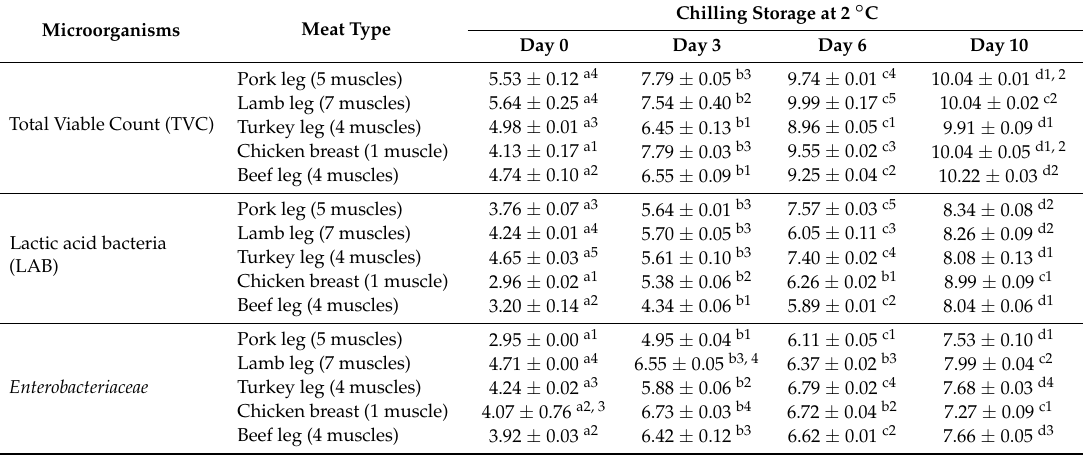
Table 2. Microbial counts Log (cfu/g) of the fresh different meat types during chilled storage at 2 ◦ C.